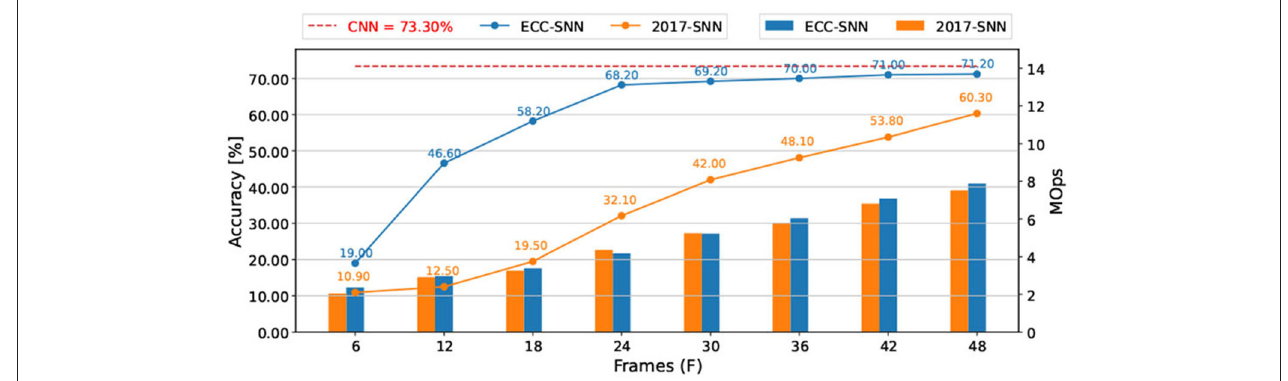
FIGURE 4 | Accuracy and energy consumption (MOps) with respect to frames, between 2017-SNN and ECC-SNN, for CIFAR-10-DVS, and VGG-7.